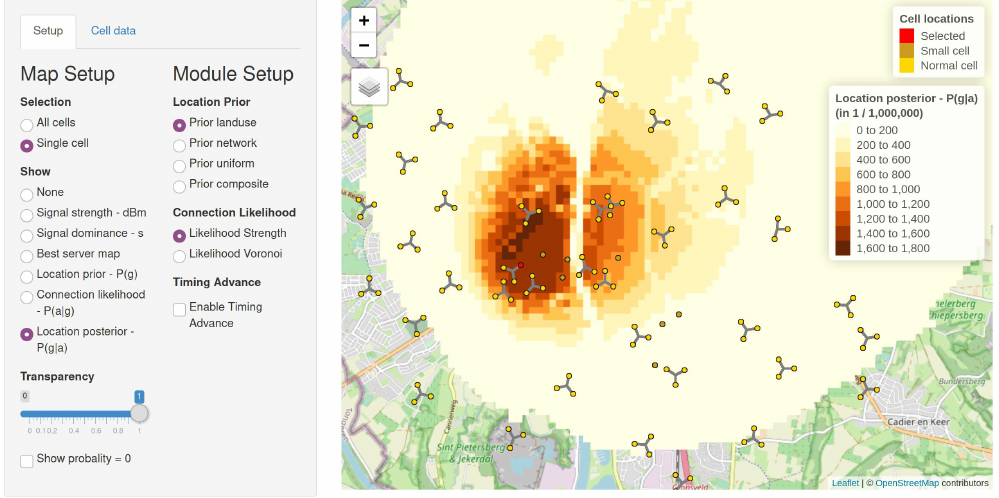
Figure 14: Screenshot of the mobloc exploration